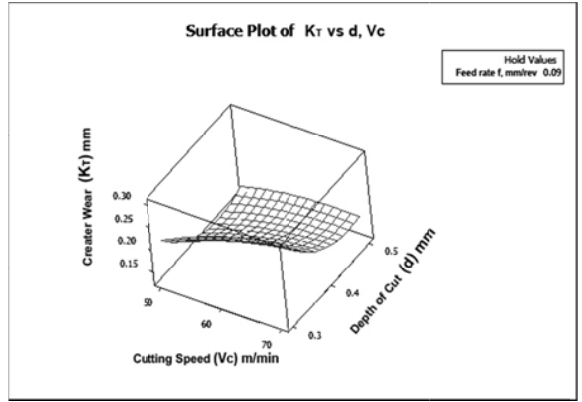
Figure 9. 3D Surface plot of K T vs. d and V c